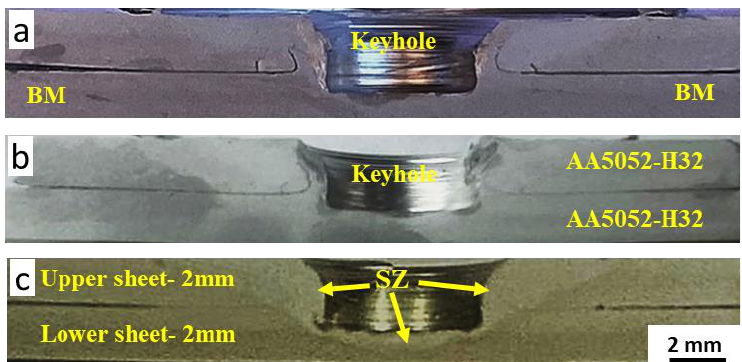
Figure 6. Macrographs of the transverse cross-sections of the FSSWed AA5052-H32 specimens processed at a constant tool rotational speed of 500 rpm and different dwell times of ( a ) 1 s, ( b ) 2 s, and ( c ) 3 s.